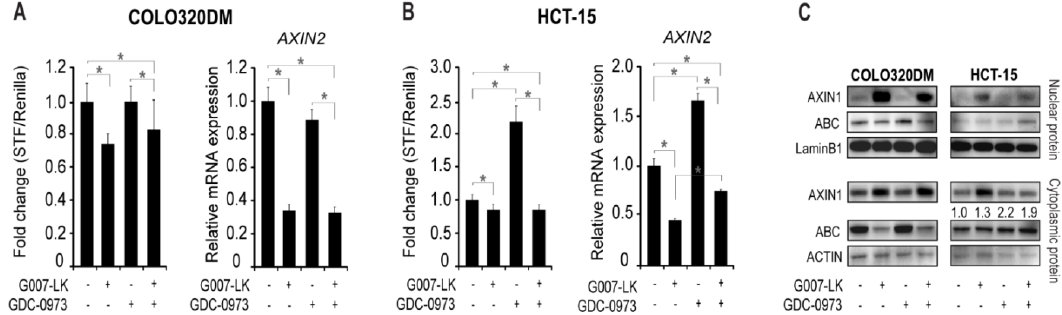
Figure 2. MEK inhibition induces canonical WNT signaling in HCT-15 cells. To reflect canonical WNT signaling upon inhibitor treatments Luciferase reporter assay was conducted on COLO320DM ( A ) and HCT-15 ( B ) cells stably transfected with SuperTop-Flash (STF) and Renilla plasmids. AXIN2 transcription levels were measured on untransfected cells. Relative gene transcription levels were normalized to internal GAPDH levels. Regulations of AXIN1 and non-phospho (active) β -catenin (ABC) protein levels were investigated by Western blot analysis in untransfected COLO320DM and HCT-15 cells ( C ). LaminB1 and ACTIN were used as loading control for the nuclear and cytoplasmic fraction, respectively. Numbers above ABC blot indicate volume measurements of ABC/ACTIN band intensity, and relative to the DMSO control. Representative graphs and immunoblots from at least 3 independent experiments are shown. Bars in ( A ) and ( B ) indicate mean relative expression values ( ± STDEV) from at least 3 technical replicates. All assays were performed after 24 h incubation with inhibitors as indicated. * p <